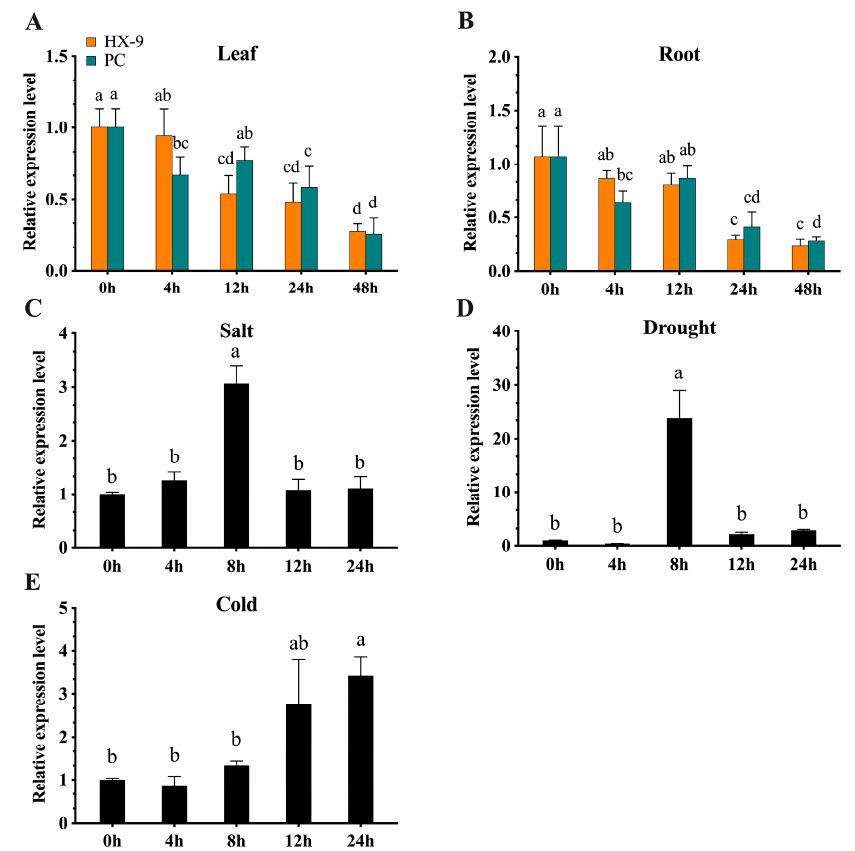
Figure 4. Expression profiles of CaBPM4 in response to P. capsici infection and abiotic stresses. ( A ) The avirulent PC strain (incompatible with the ‘A3’ pepper cultivar) and the virulent HX-9 strain (compatible with ‘A3’) of P. capsici infection in roots; ( B ) the avirulent PC strain (incompatible with the ‘A3’ pepper cultivar) and the virulent HX-9 strain (compatible with ‘A3’) of P. capsici infection in leaves; ( C ) salt stress; ( D ) drought stress; ( E ) cold stress. Relative expression levels of the CaBPM4 at different time point were determined in comparison with that in the control plants at the corresponding same time point. Results are presented as mean means ± SD of three independent biological replicates. Small letters (a–d) represent significant differences ( p < 0.05).